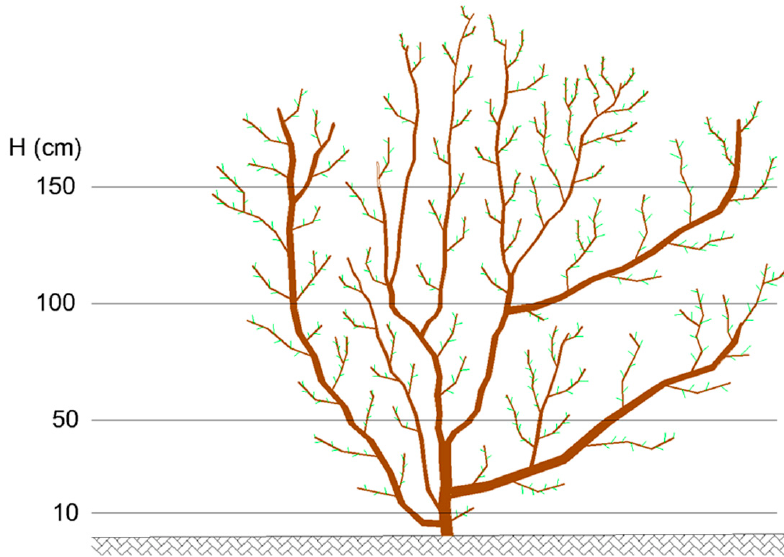
Figure 6. Diagram of the shrub with deflection measurement levels indicated.